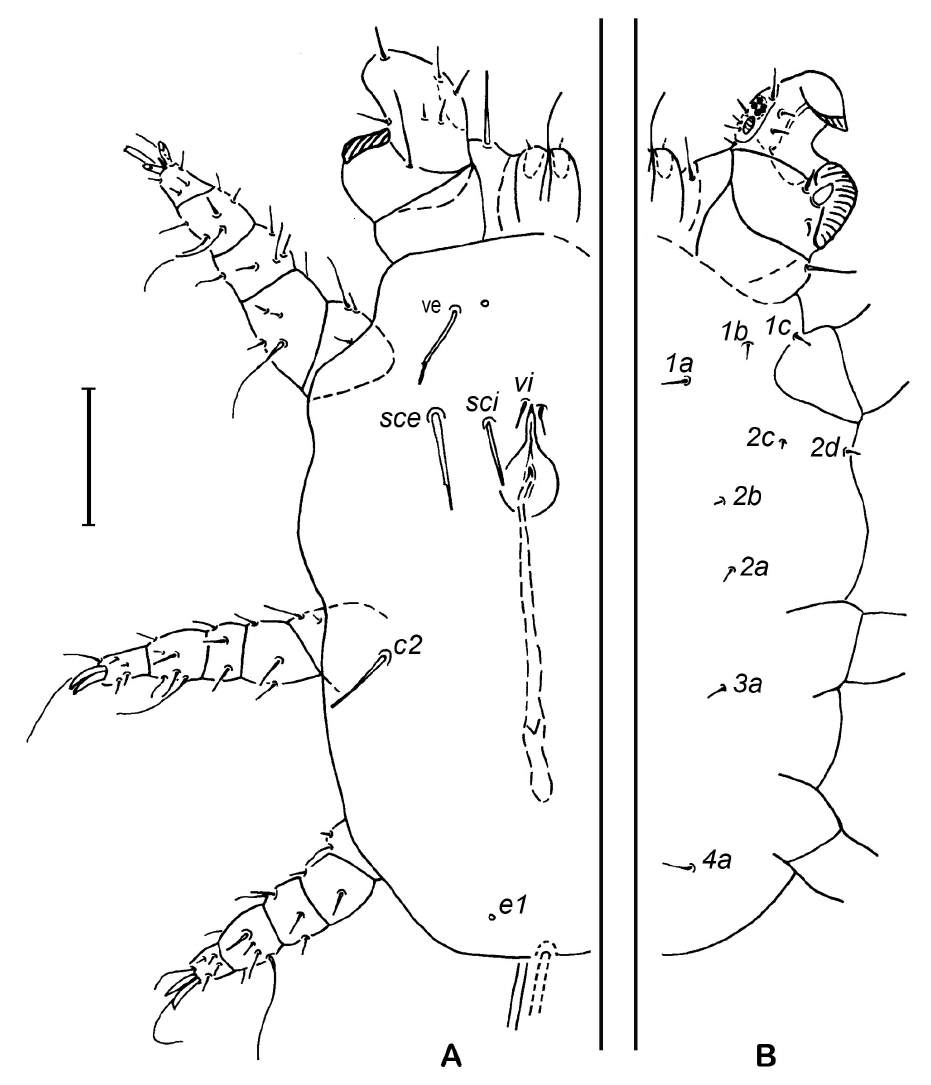
Figure 2. Ioanella mimon , male. A Dorsal view B Ventral view. Scale bar: 50 μm.